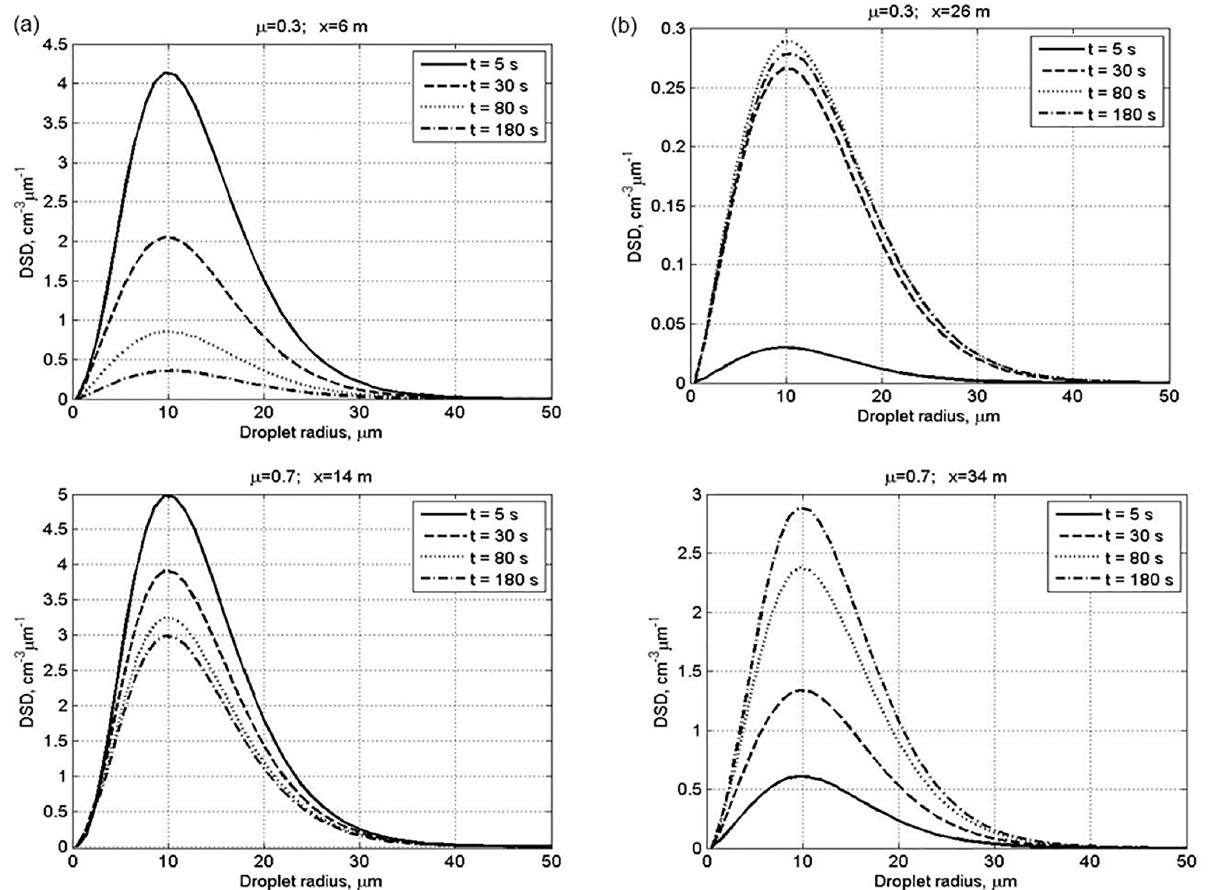
Figure 4. The same as in Fig. 3 but for the initially wide